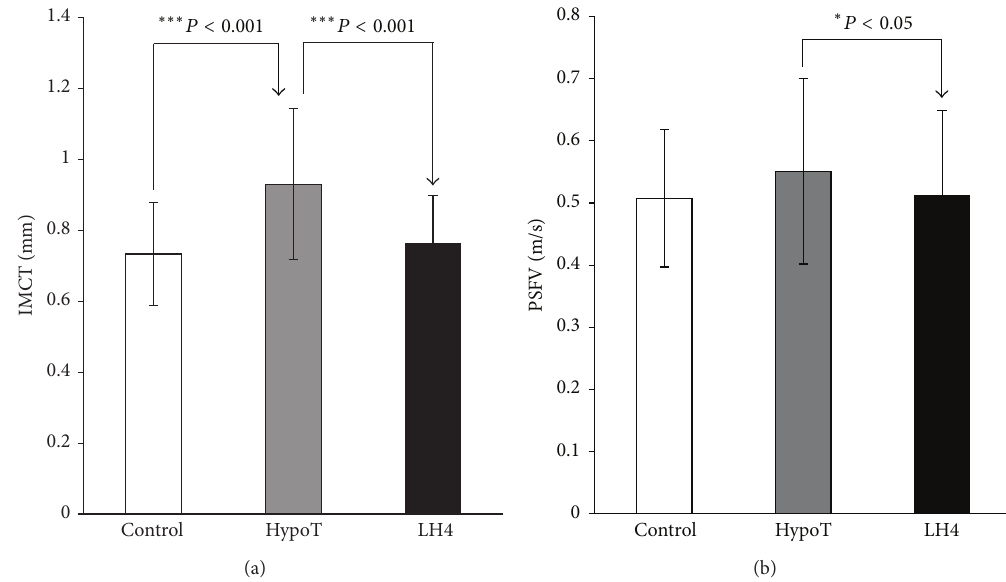
Figure 3: (a) Intima media complex thickness (IMCT) and (b) peak systolic flow velocity (PSFV) in control and hypothyroid patients before (HypoT) and after treatment with LT4 (LT4). Values are given as mean ± SD. 0.358 ; 𝑃 < 0.05 ) (Figure 4(c)) and IMCT and DBP after